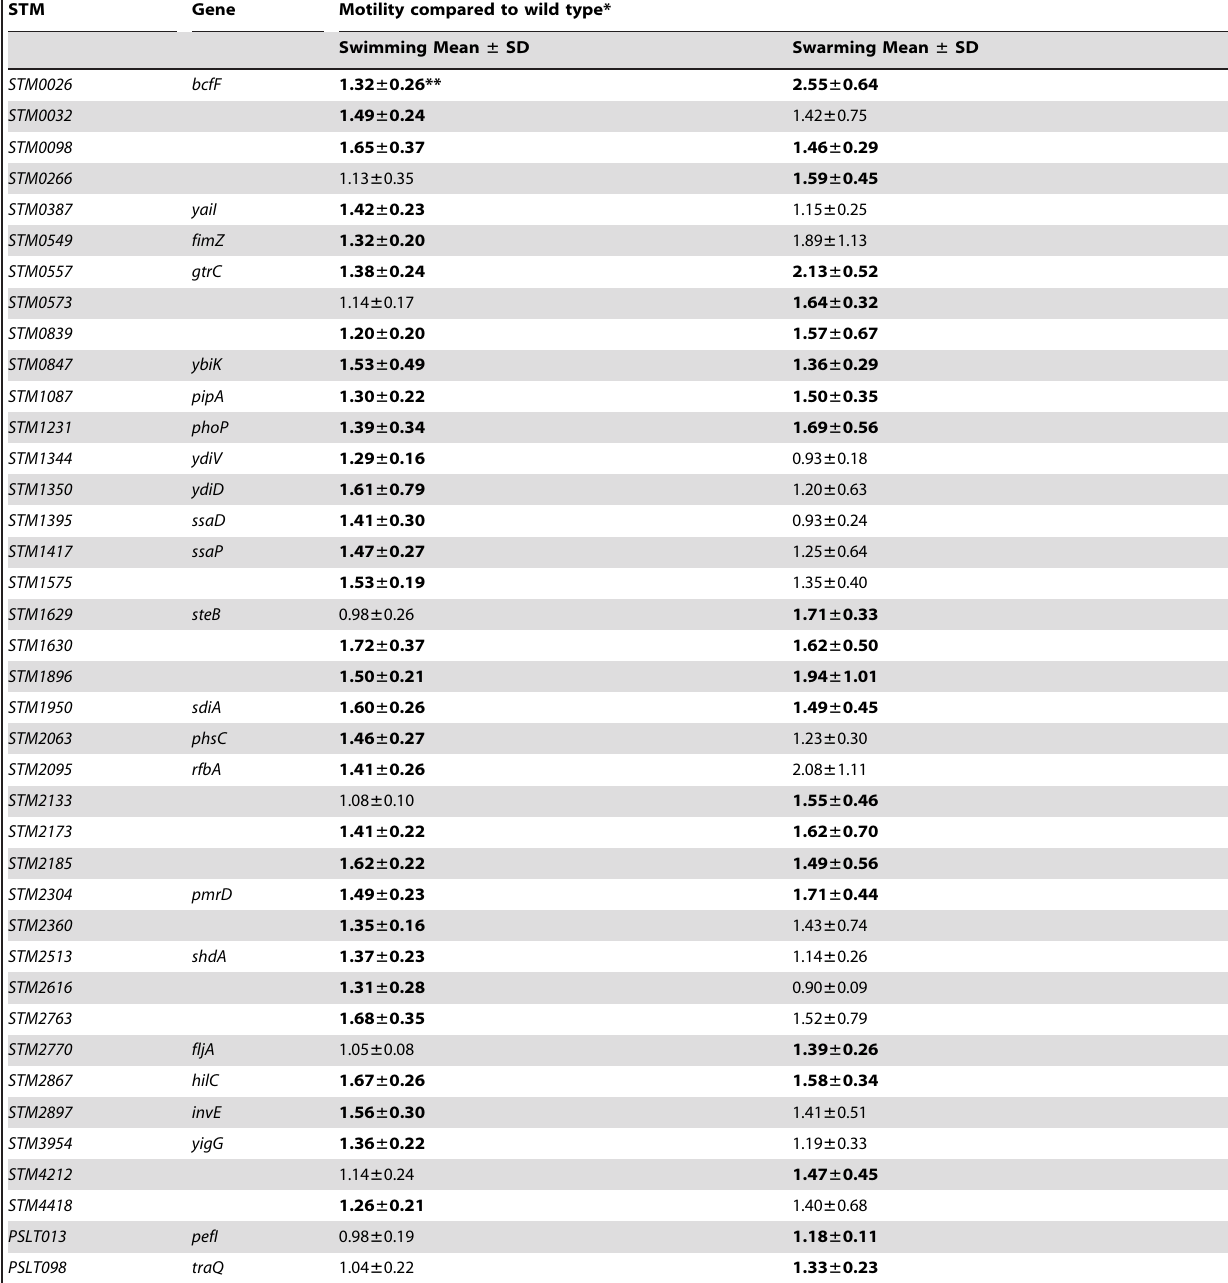
Table 2. Mutants with enhanced